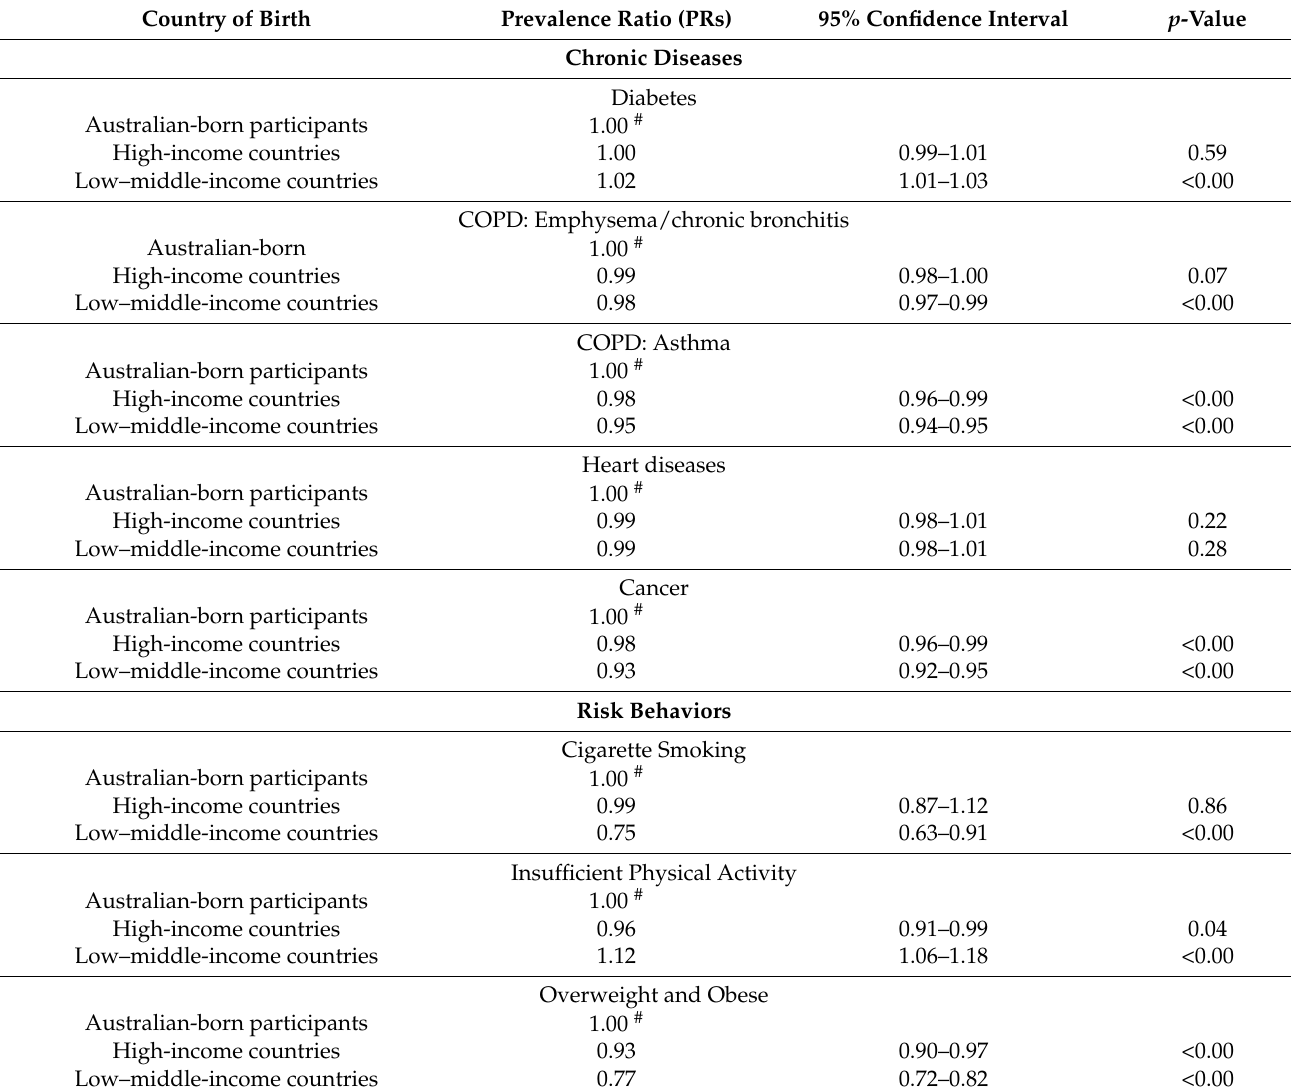
Table 2. Prevalence ratios (PRs) ¥ of chronic diseases by country of birth and prevalence ratios (PRs) ¥ of risk factors by country of birth. Country of Birth Prevalence Ratio (PRs) 95% Confidence Interval p